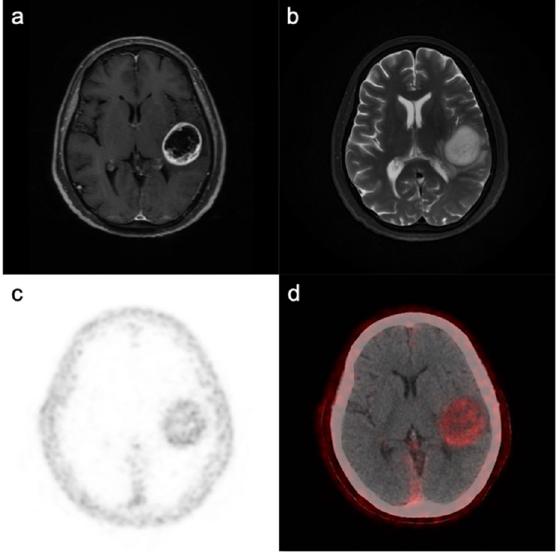
Figure 2. Magnetic resonance imaging (MRI) and FAPI PET/CT in GBM. An IDH-wildtype GBM from a 71-year-old woman displayed ring-like contrast enhancement with hypointense T1-weighted and hyperintense T2-weighted signals ( a , b ) from central tissue. 68 Ga-FAPI PET and merged PET/CT images ( c , d ) showed elevated radioactivity in the whole tumor area (including ring-like contrast enhancement and noncontrast-enhanced tissue).